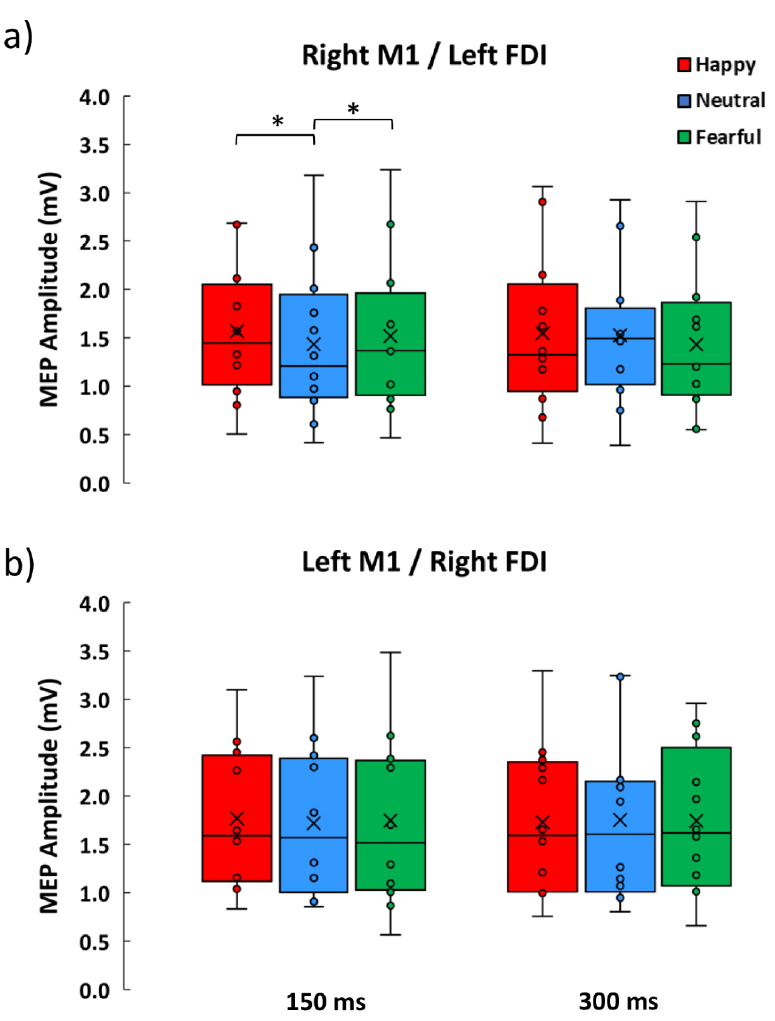
Figure 2. Boxplots showing MEP amplitudes recorded during the presentation of happy, neutral and fearful facial expressions at 150 and 300 ms from the stimulus onset. ( a ) Data from the right M1 experiment showing an early increase of MEPs for emotional facial expressions. ( b ) Data from the left M1 showing no MEP modulation. Asterisks denote significant Wilcoxon comparisons ( p < 0.05).